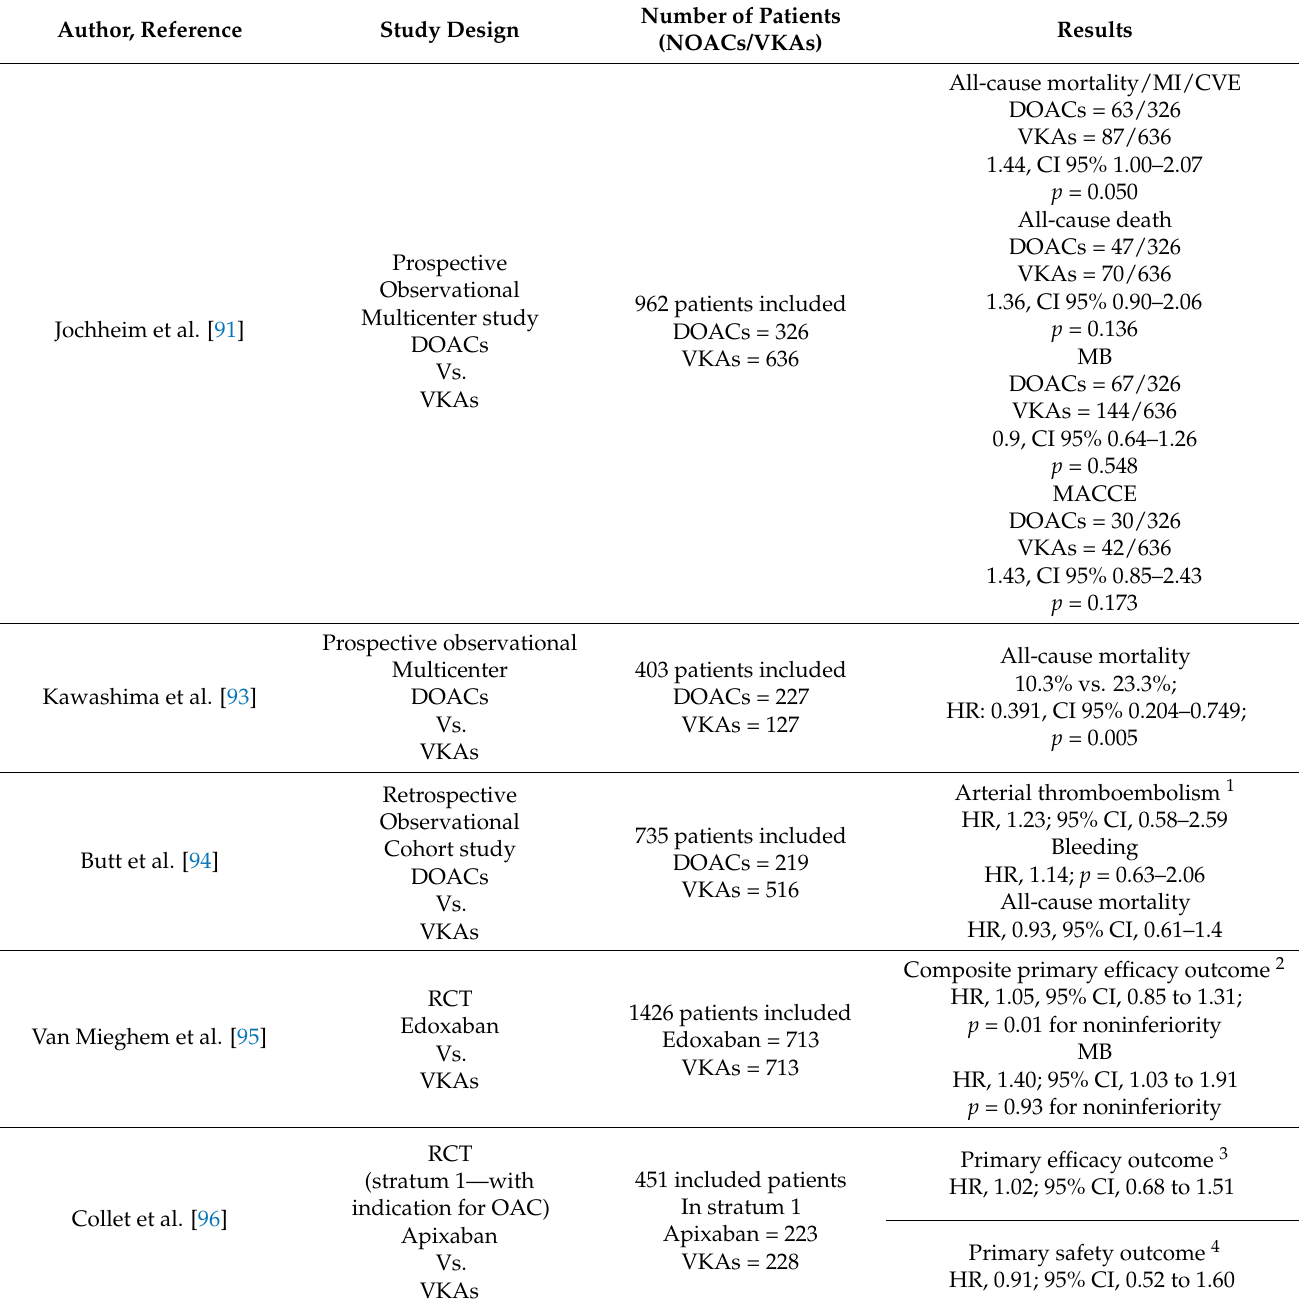
Table 7. Characteristics and results of the studies comparing Direct oral anticoagulants with vitamin K antagonist oral anticoagulants in AF patients after